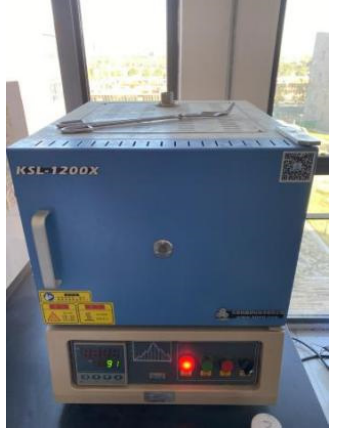
Figure 1. Box-type high-temperature fritting furnace.